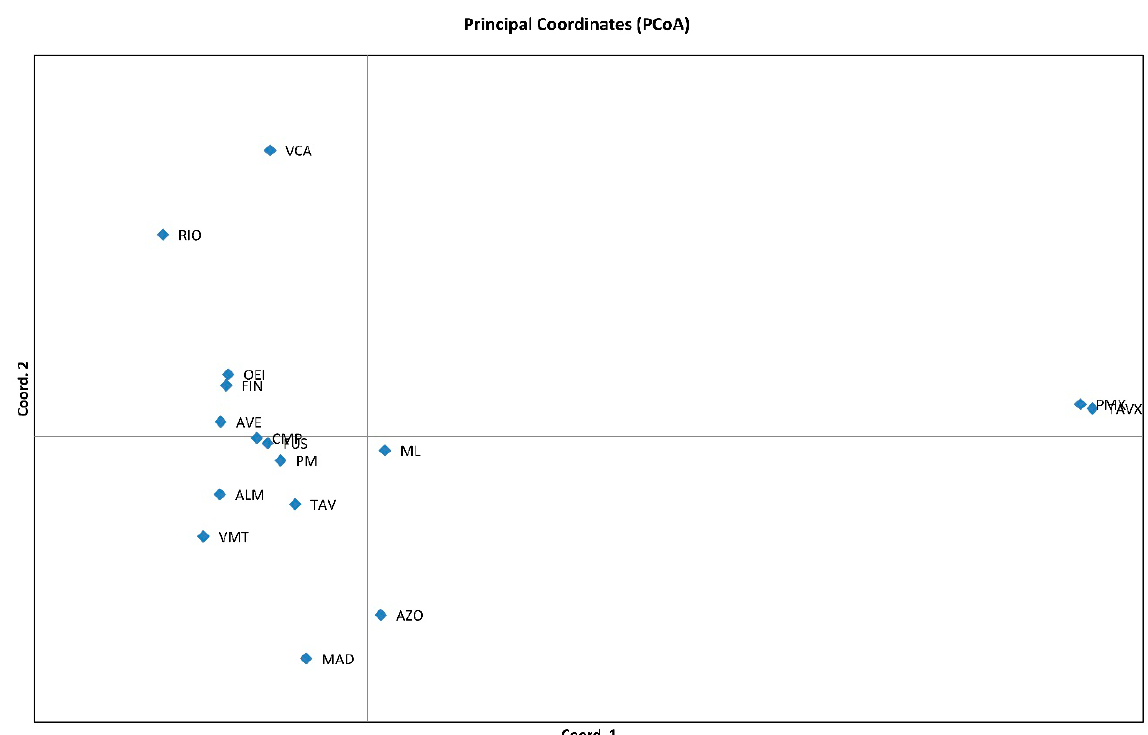
Figure 2. Scatter plot of the first and second principal coordinate based on the genetic variation of 6 SSR loci for 390 in- dividuals of wild beet, from 16 populations. The explained variation in the first coordinate is 50.75% and in the second coordinate is 12.85%.